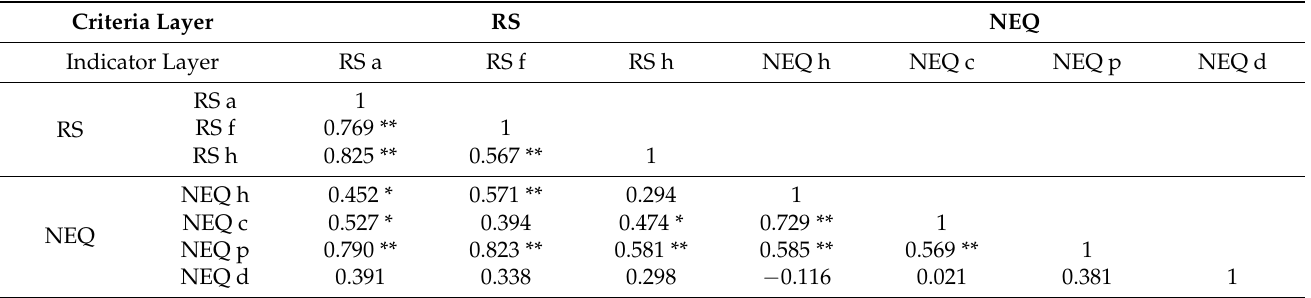
Table 3. Correlation analysis between the spatial characteristics of the waterfront.